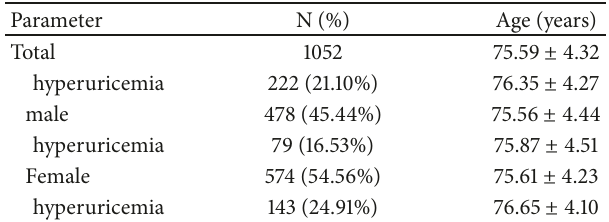
Table 1: General clinical characteristics of hyperuricemia in